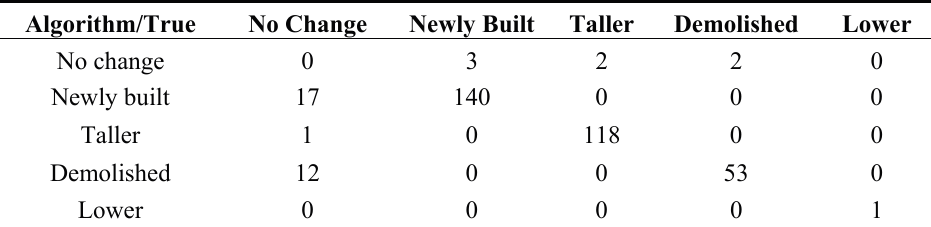
Table 2. Confusion matrix with change